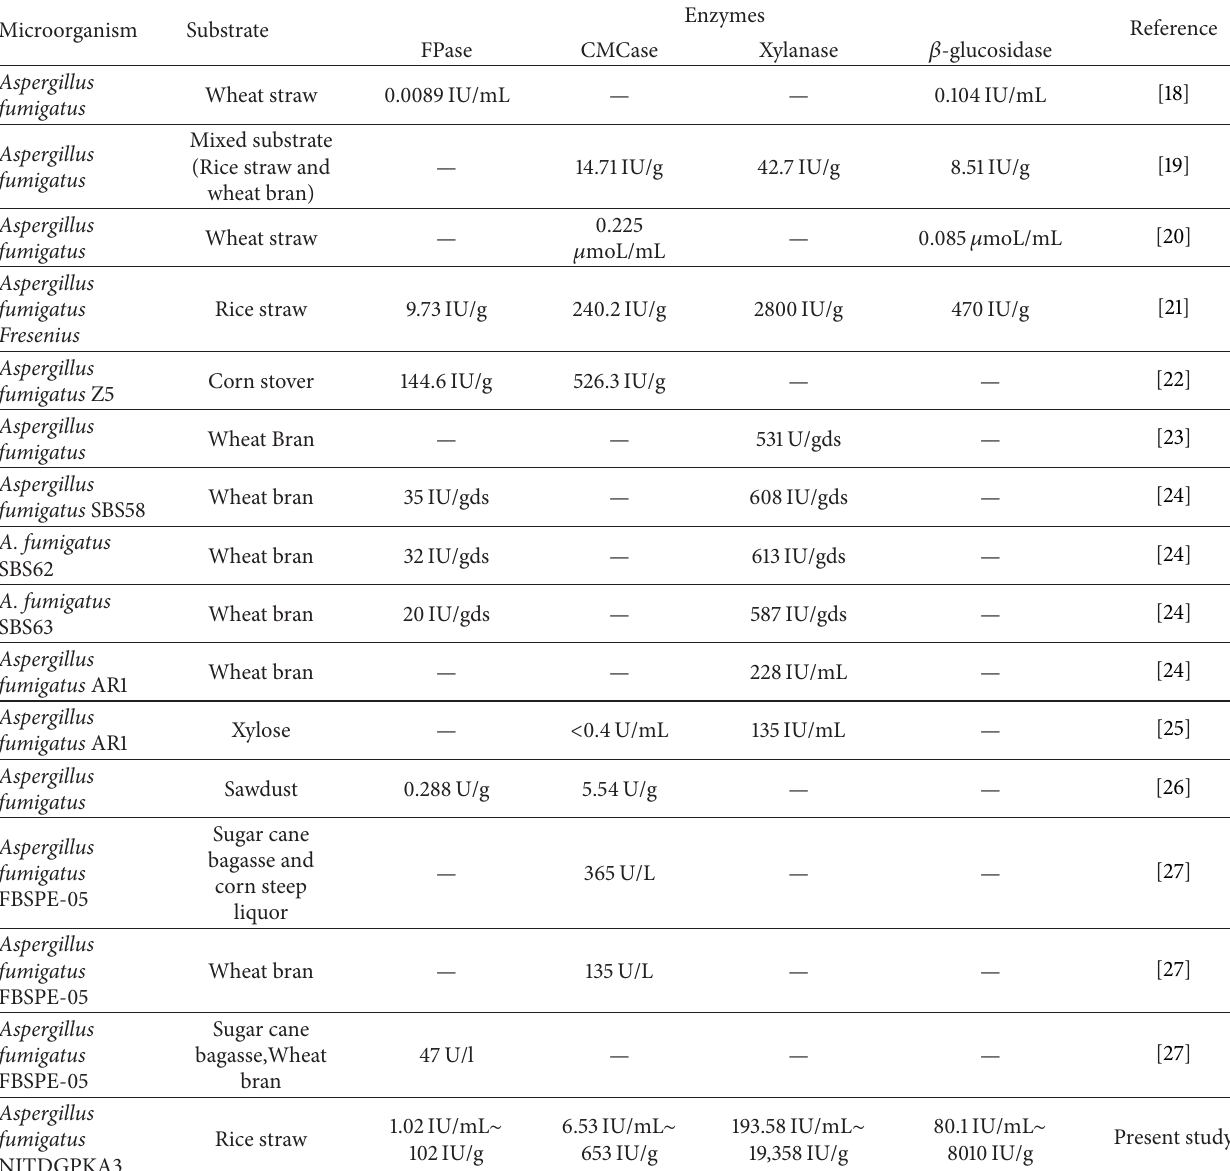
Table 3: Comparison of cellulase and xylanase production by Aspergillus fumigatus NITDGPKA3 with other strain of Aspergillus fumigatus. Microorganism